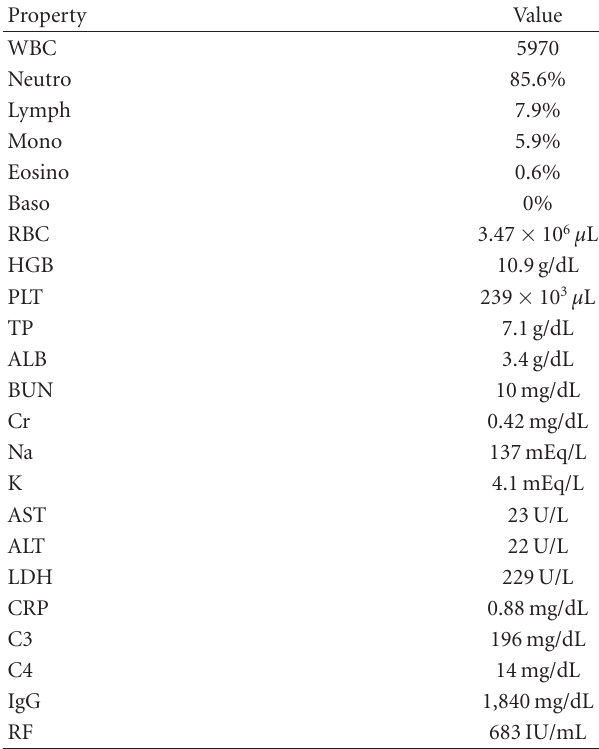
Table 1: Laboratory data for the